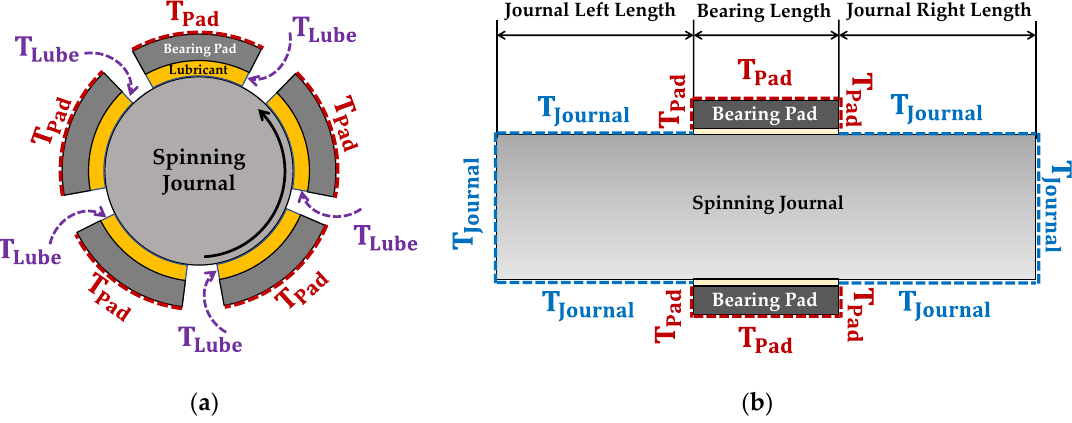
Figure 8. Thermal boundary conditions around bearing-lubricant-shaft numerical model: ( a ) cross-section view; ( b ) side view.